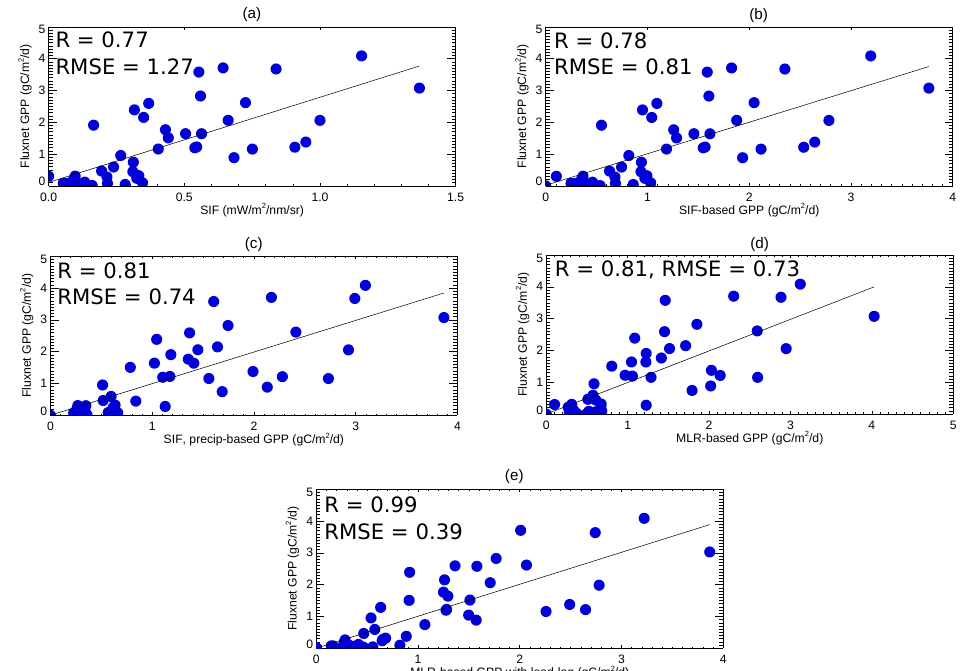
Figure 6. Relationship of mean monthly GPP (gC/m 2 /day) measured at FLUXNET stations with C3 non-arctic grass vegetation (Table 1) used in this study and ( a ) GOME-2 SIF; ( b ) SIF-based GPP; ( c ) SIF- and precipitation-based GPP; ( d ) MLR-based GPP (SIF, precipitation, soil moisture as predictors); ( e ) MLR-based GPP with lead–lag. The Spearman’s correlation coefficient R and root-mean-square error RMSE (gC/m 2 /day) are shown.